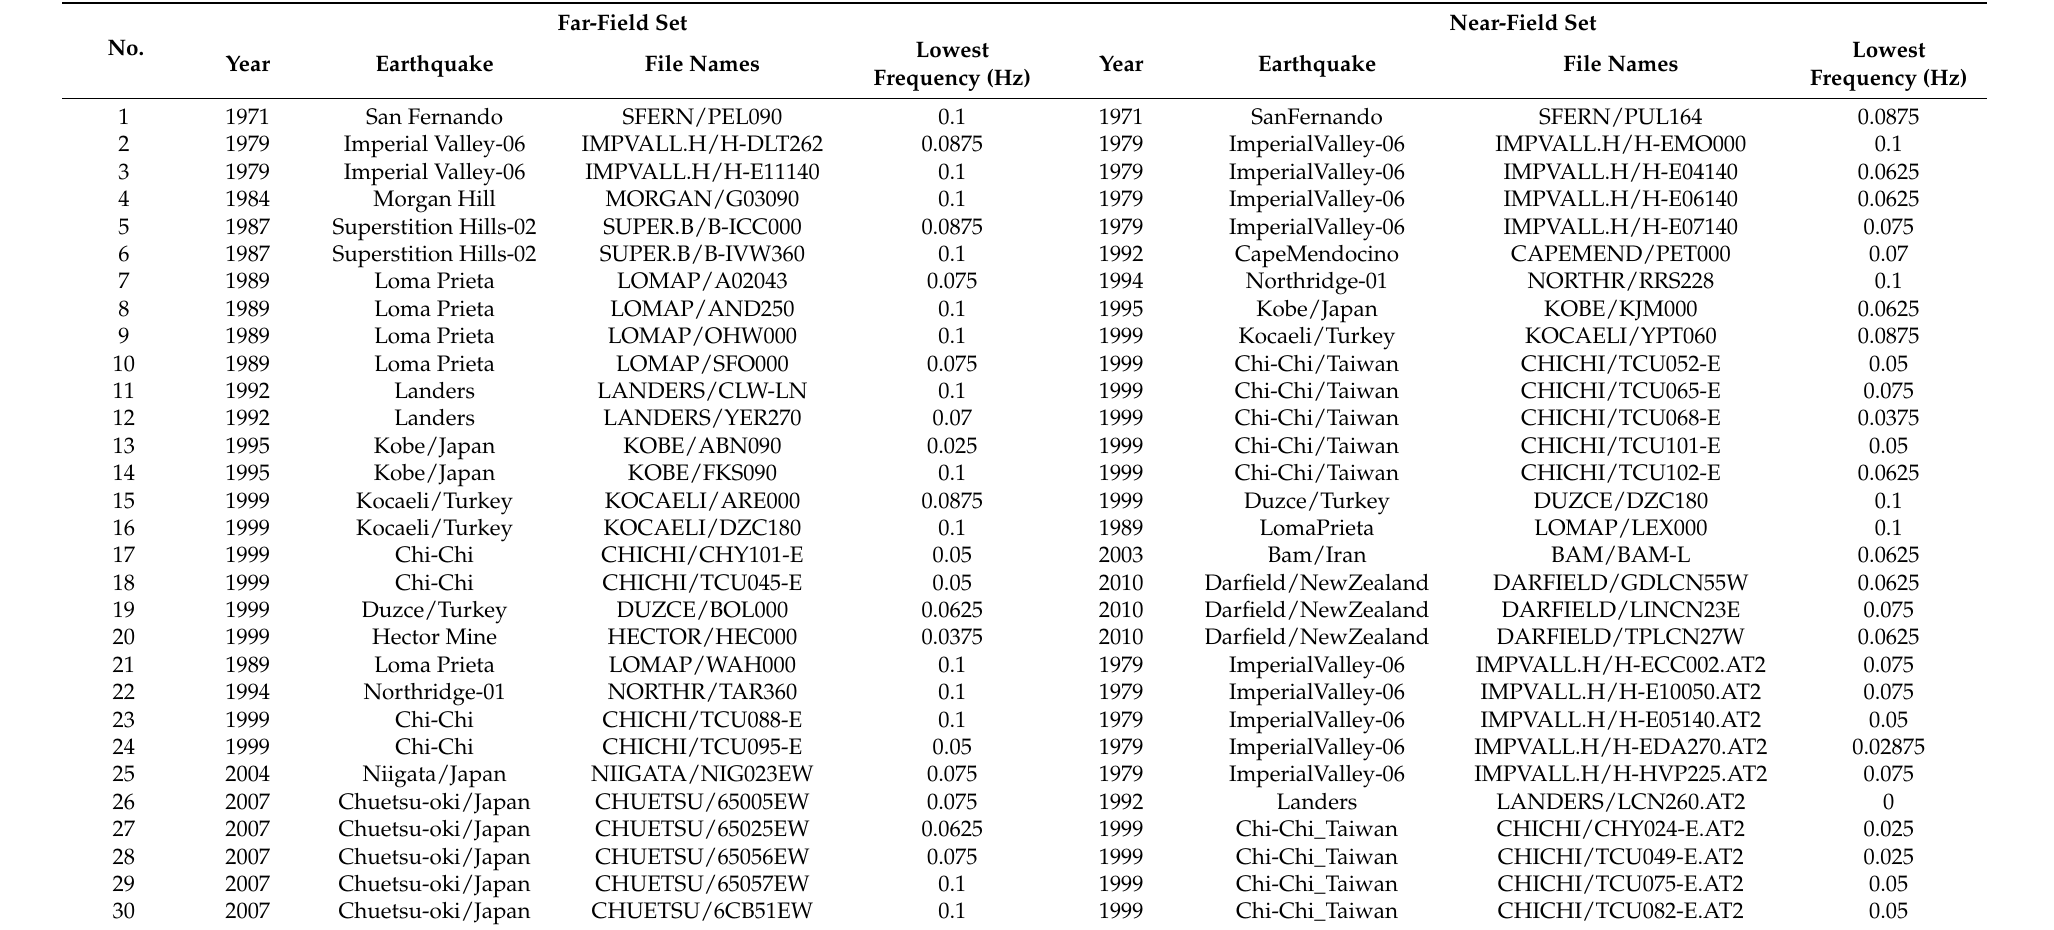
Table 3. Selected ground